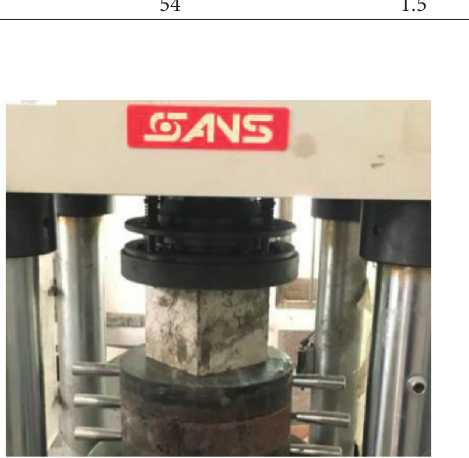
Figure 1: The hydraulic